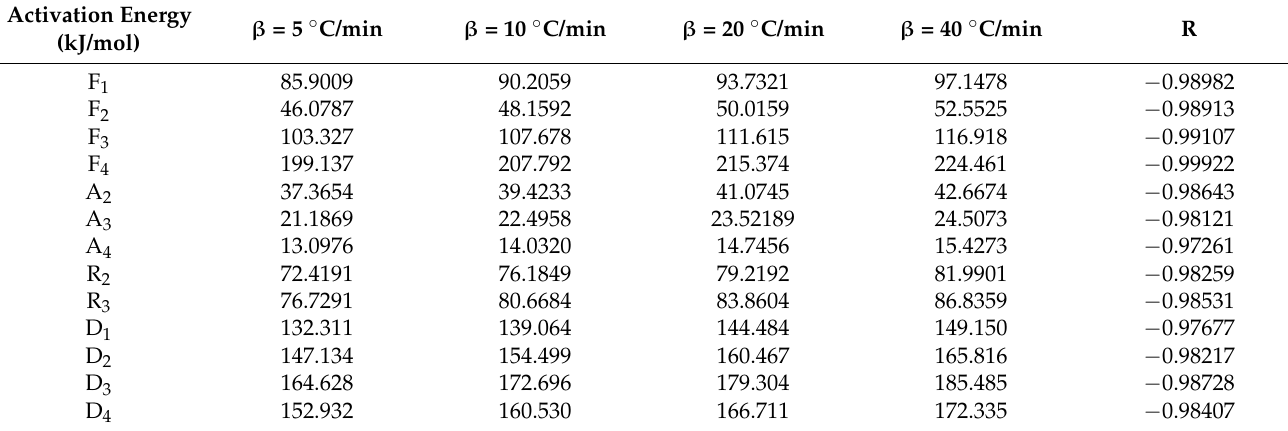
Table 4. Correlation coefficients corresponding to various mechanism function for the plot ln(F/T 2 )-1/T at different heating rates. Activation